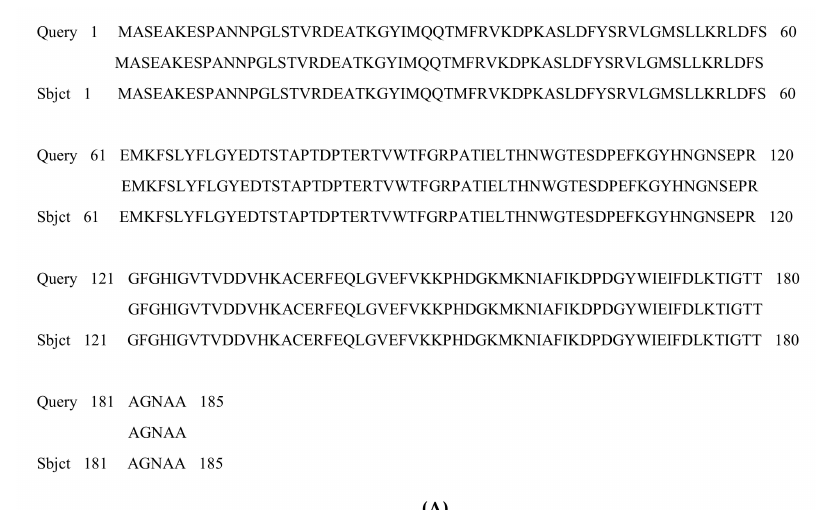
Figure 6. Nucleotide sequence of Jo-glo1 from jojoba with gly-1 ( glyoxalase I ) of the coding region of the gene confers tolerance in plants under stress; glyoxalase I gene from Brassica juncea (Accession number: embY13239.1, glyoxalase I Length = 775). The underlined regions correspond to the primers used for PCR amplification.